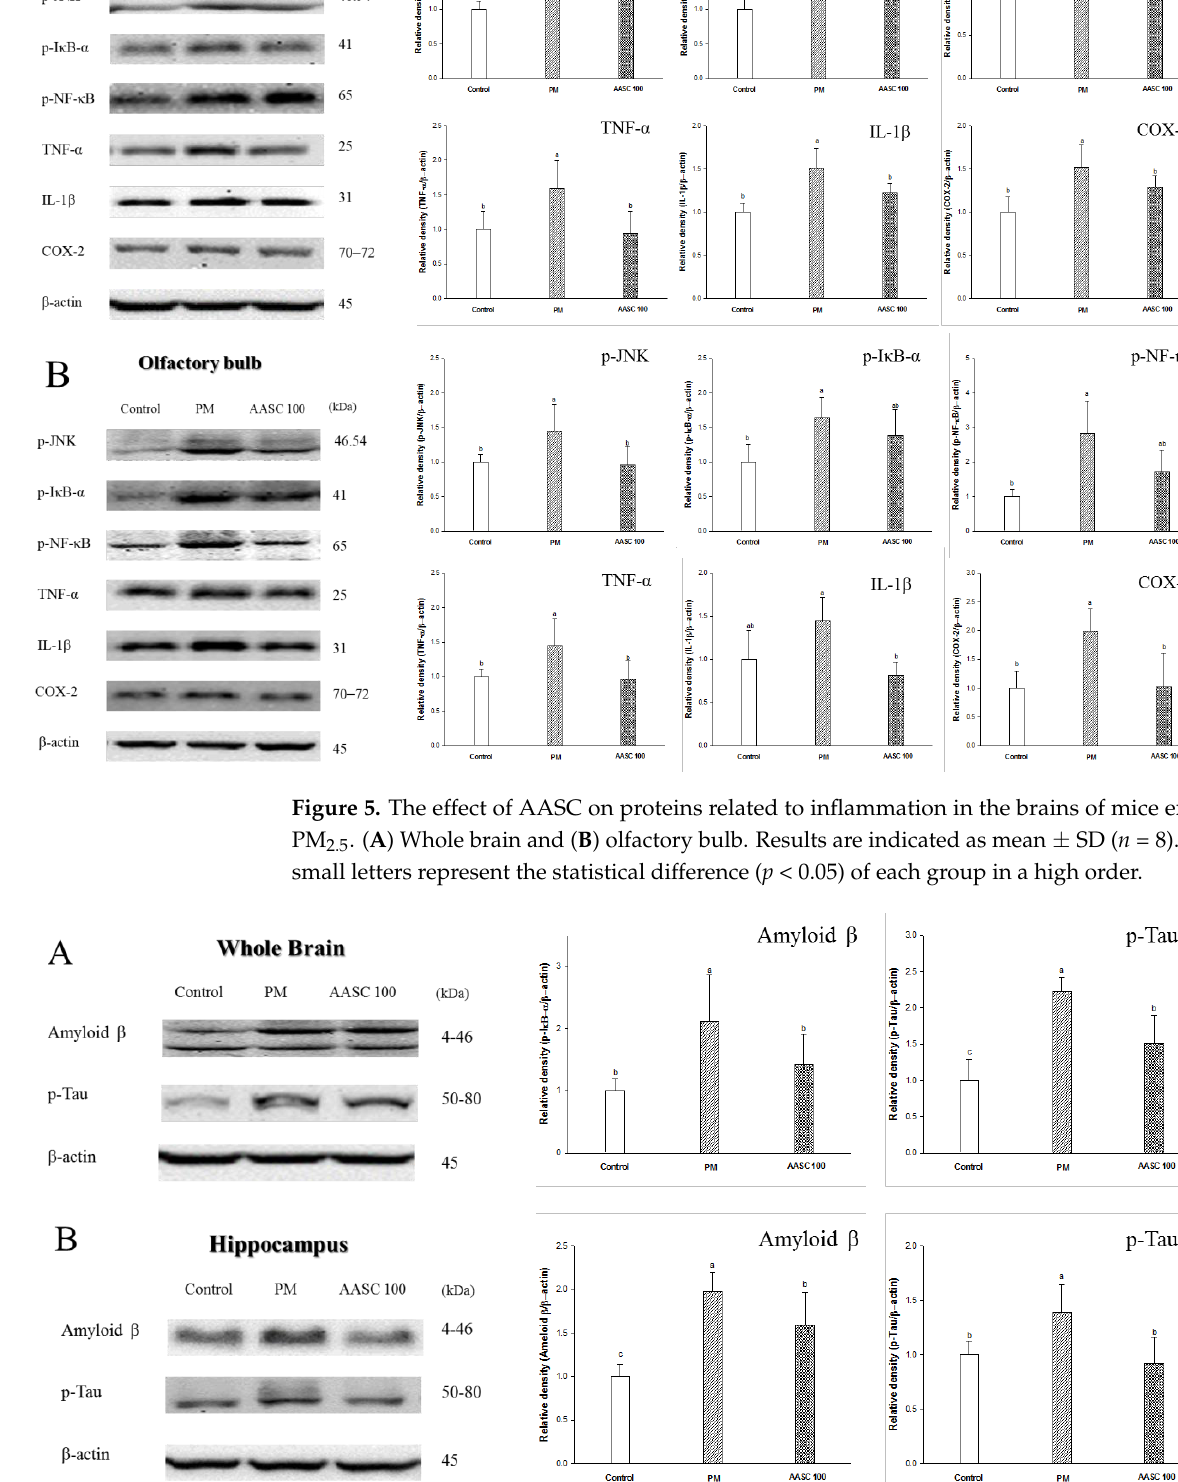
Figure 7. The effect of AASC on proteins related to apoptosis in the brains of mice exposed to PM 2 . 5 . Results are indicated as mean ± SD (n = 8). Different small letters represent the statistical difference ( p < 0.05) of each group in a high order. 3. Materials and Methods 3.1. Sample Preparation 3.1.1. Sample Extraction A. argyi registered in a local-specific resource in the Korean Forest Service variety protection registration (No. 42, 27 September 2013) was provided by the Namhae Agricul- tural Association Corporation (Namhae, Korea) [57]. S. chinesis was cultivated in Yeongju (Korea) and purchased from duson-aeyagcho (Yeongcheon, Korea). A. argyi and S. chinesis were ground and then extracted with distilled water at 40 °C for 2 h. After A. argyi and S.